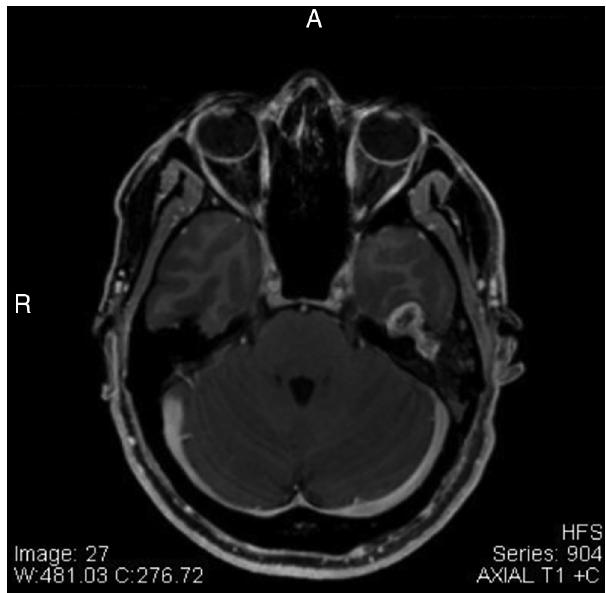
Figure 1 Axial T1-weighted magnetic resonance imaging with contrast showing lesion located next to the geniculate ganglion and tympanic portion of the facial nerve to the left. The choice of surgical approach was decided, considering the findings and neurosurgery team assessment. Pure tone audiometry showed moderate conductive loss to the left and normal hearing to the right. Impedance audiometry resulted in curve type A, bilaterally. Electromyo- graphy was compatible with partial lesion of the left facial nerve, demonstrating severe intensity and signs of activity without fibrillation. CT scan of the temporal bones showed a mass in the tympanic region of the facial nerve, compressing the ossicles. Tegmen erosion was observed, with probable maintenance of dura mater. The patient underwent surgery, which unveiled a lesion in the projection of the geniculate ganglion in the petrous portion of the temporal bone, with extradural extension that was soft, poorly vascularized, and extending to the mastoid facial canal. Presence of viable facial nerve near the stylo- mastoid foramen was observed. The lesion was resected and greater auricular nerve grafting was performed. The patient persisted with Grade IV paralysis postopera- tively. Histopathological examination disclosed the presence of cell schwannoma, with geniculate ganglion free of neo- plastic